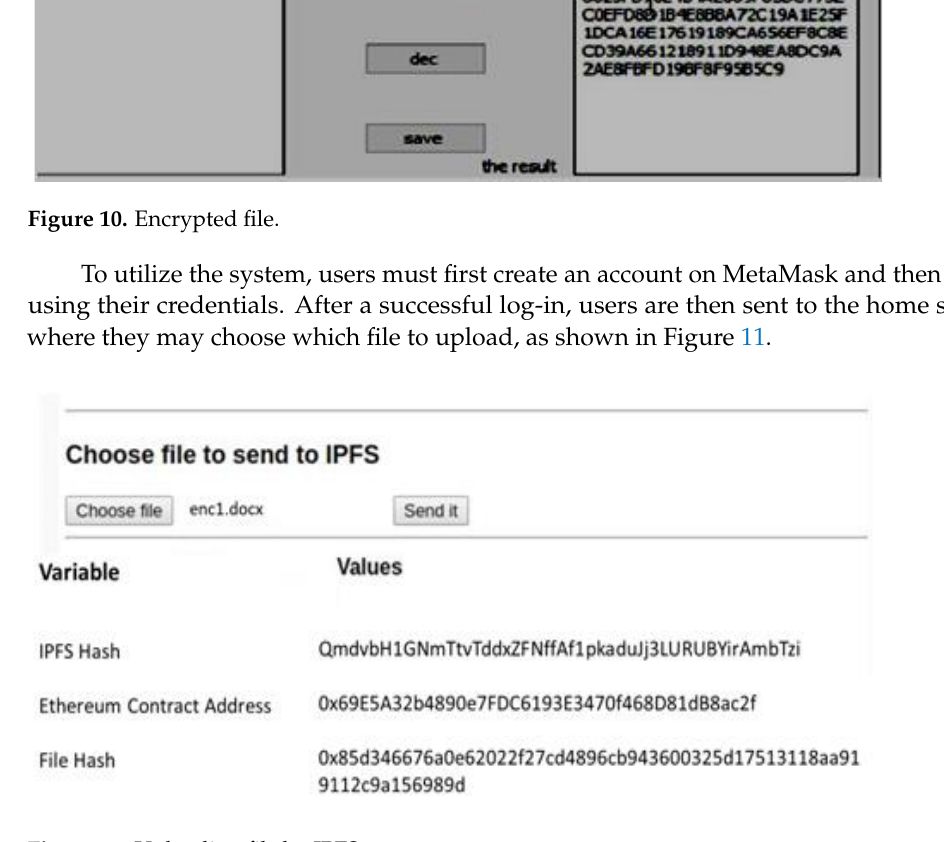
Figure 11. Uploading file by